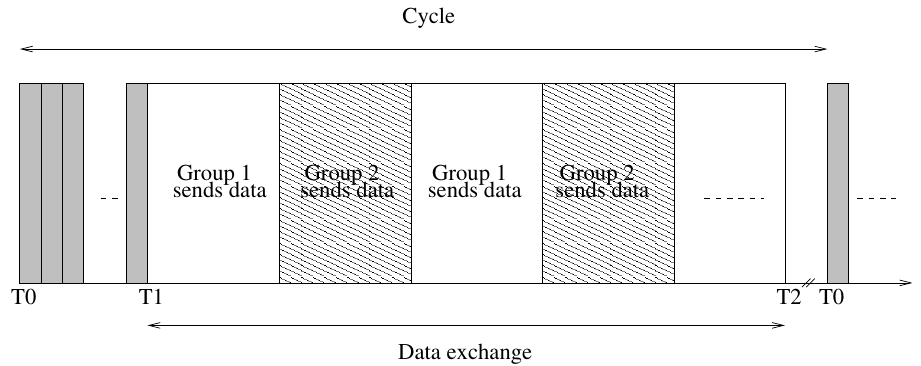
; T ] is a synchronization period, [ T 0 1